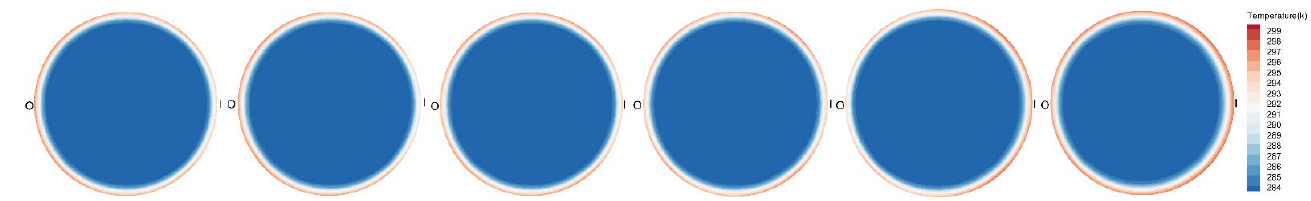
Figure 15. Temperature distributions on the five sections and the outlet plane of the U ‐ shaped chan ‐ nel. From the left to the right, the order of these sections is from the inlet to the outlet of the channel. In this case, the inlet velocity is 0.5 m/s. The temperature boundary conditions are: 300 K on the wall and 283 K of the incoming fluid at the inlet. inside, and therefore the most rotational flow is outside the plug and near the edge. end of the bend.